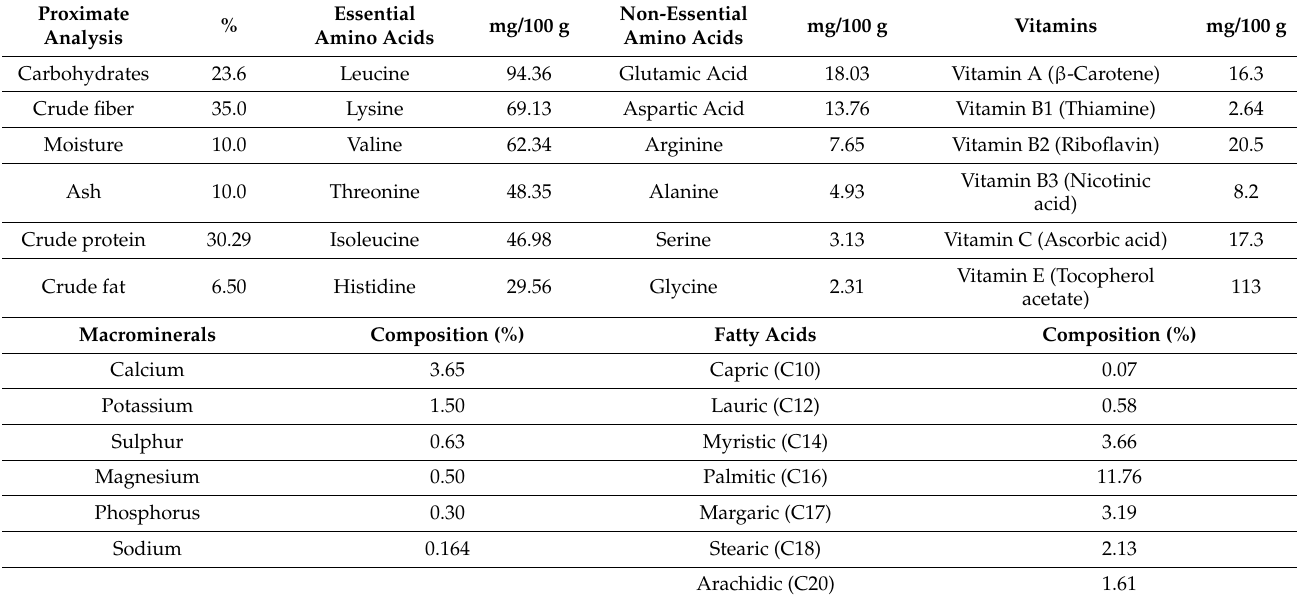
Table 1. Chemical composition of M. oleifera (adapted from Moyo et al. [55]; Aja et al. [56]; Sobhy et al.